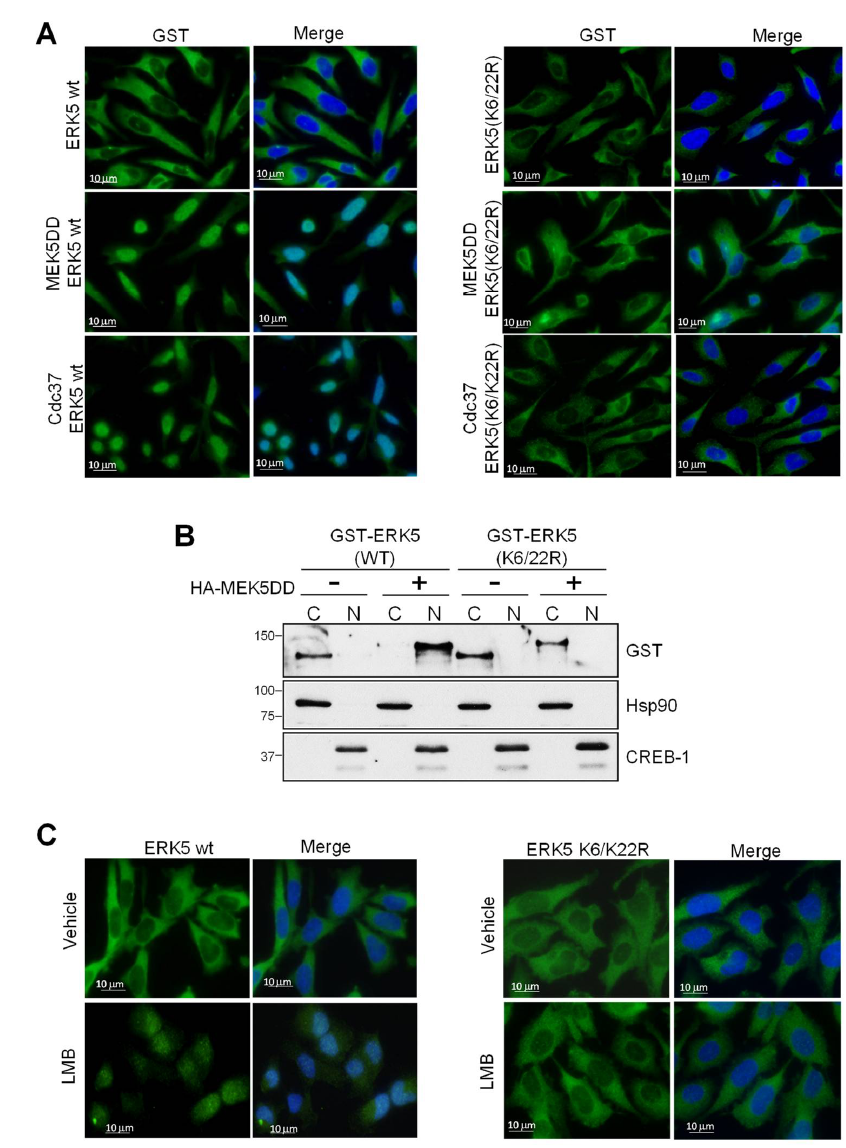
Figure 2. ERK5 requires SUMO modification for nuclear translocation. Immunofluorescence Figure2. ERK5requiresSUMO modificationfor nucleartranslocation. Immunofluorescencemicroscopy. ( A ) PC-3 cells were transfected with either GST-tagged ERK5 (wild type or K6 / 22R SUMO-deficient mutant) and MEK5DD or Cdc37 plasmids. After 24 h, cells were fixed with paraformaldehyde and immunofluorescent staining for ERK5 (green) using anti-GST antibody. Nuclei were stained with Hoechst (blue). ( B ) Subcellular fractionation. PC-3 cells were transfected with the indicated vectors and submitted to cellular fractionation as described in the Materials and Methods section. Proteins were detected by immunoblot using the indicated antibodies. ( C ) PC-3 cells were transfected with either GST-tagged ERK5 wild type (WT) or K6 / 22 mutant, left alone or treated with the nuclear export inhibitor leptomycin B (LMB, 20 nM) for 18 h and stained as in A. Similar results were obtained in three independent experiments. Scale bars, 10 µ